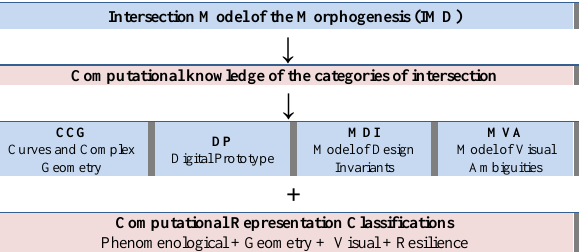
Figure 8 . Intersection Model of the Morphogenesis